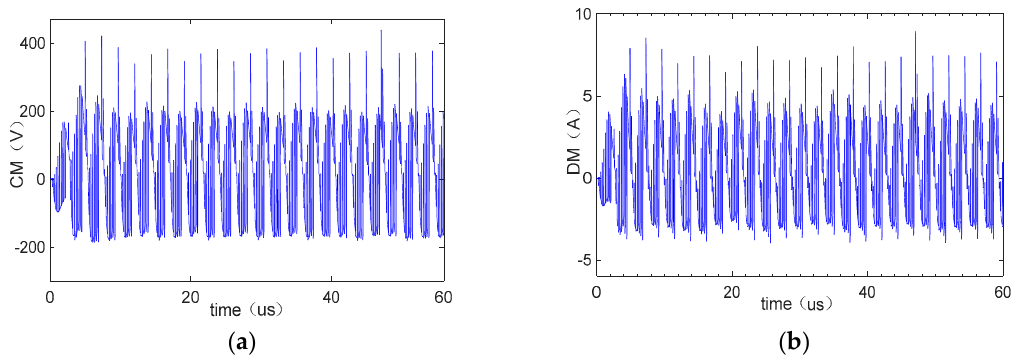
Figure 8. Noise source ( a ) common mode (CM) source; ( b ) differential mode (DM) source.